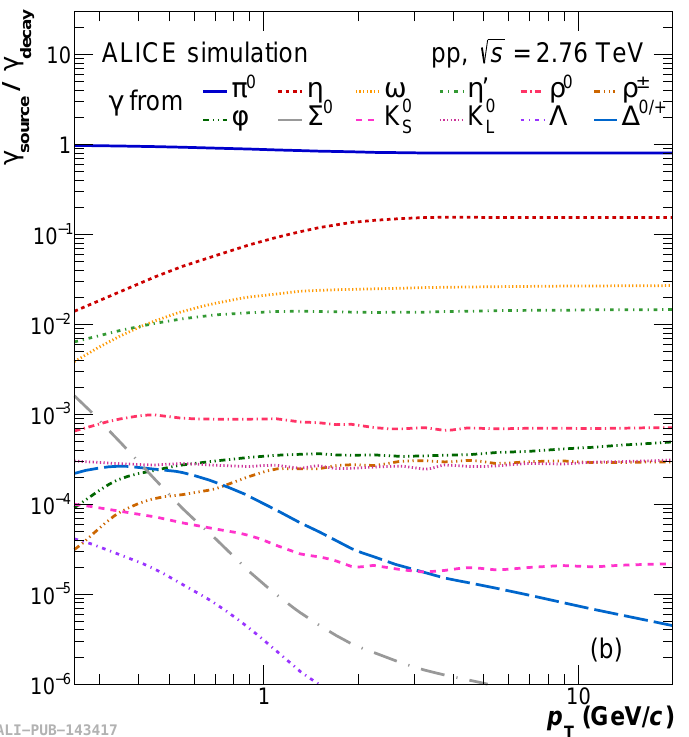
Figure 3. Ratio of decay photons from different sources to all decay photons in the decay photon simulation of pp collisions at √ s = 2.76 TeV